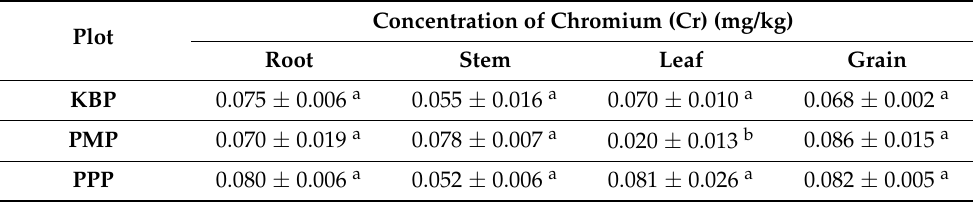
Table 7. Concentration of chromium in different parts of paddy plants collected from Kelantan. Concentration of Chromium (Cr) (mg/kg) Plot Root Stem Leaf Grain KBP 0.075 ± 0.006 a 0.055 ± 0.016 a 0.070 ± 0.010 a 0.068 ± 0.002 a PMP 0.070 ± 0.019 a 0.078 ± 0.007 a 0.020 ± 0.013 b 0.086 ± 0.015 a PPP 0.080 ± 0.006 a 0.052 ± 0.006 a 0.081 ± 0.026 a 0.082 ± 0.005